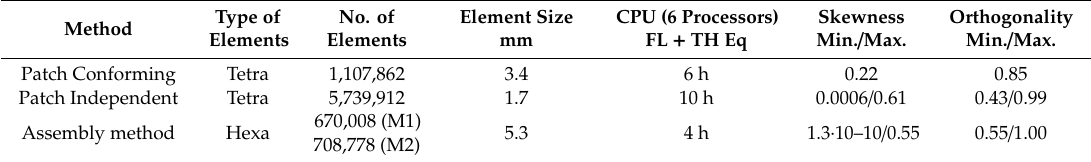
Figure 2. Graphical comparison of the evolution of calculation of Mass-Weighted Average Velocity Magnitude through the selected nozzle of a 5-strand asymmetric tundish during validation of a computational mesh type.